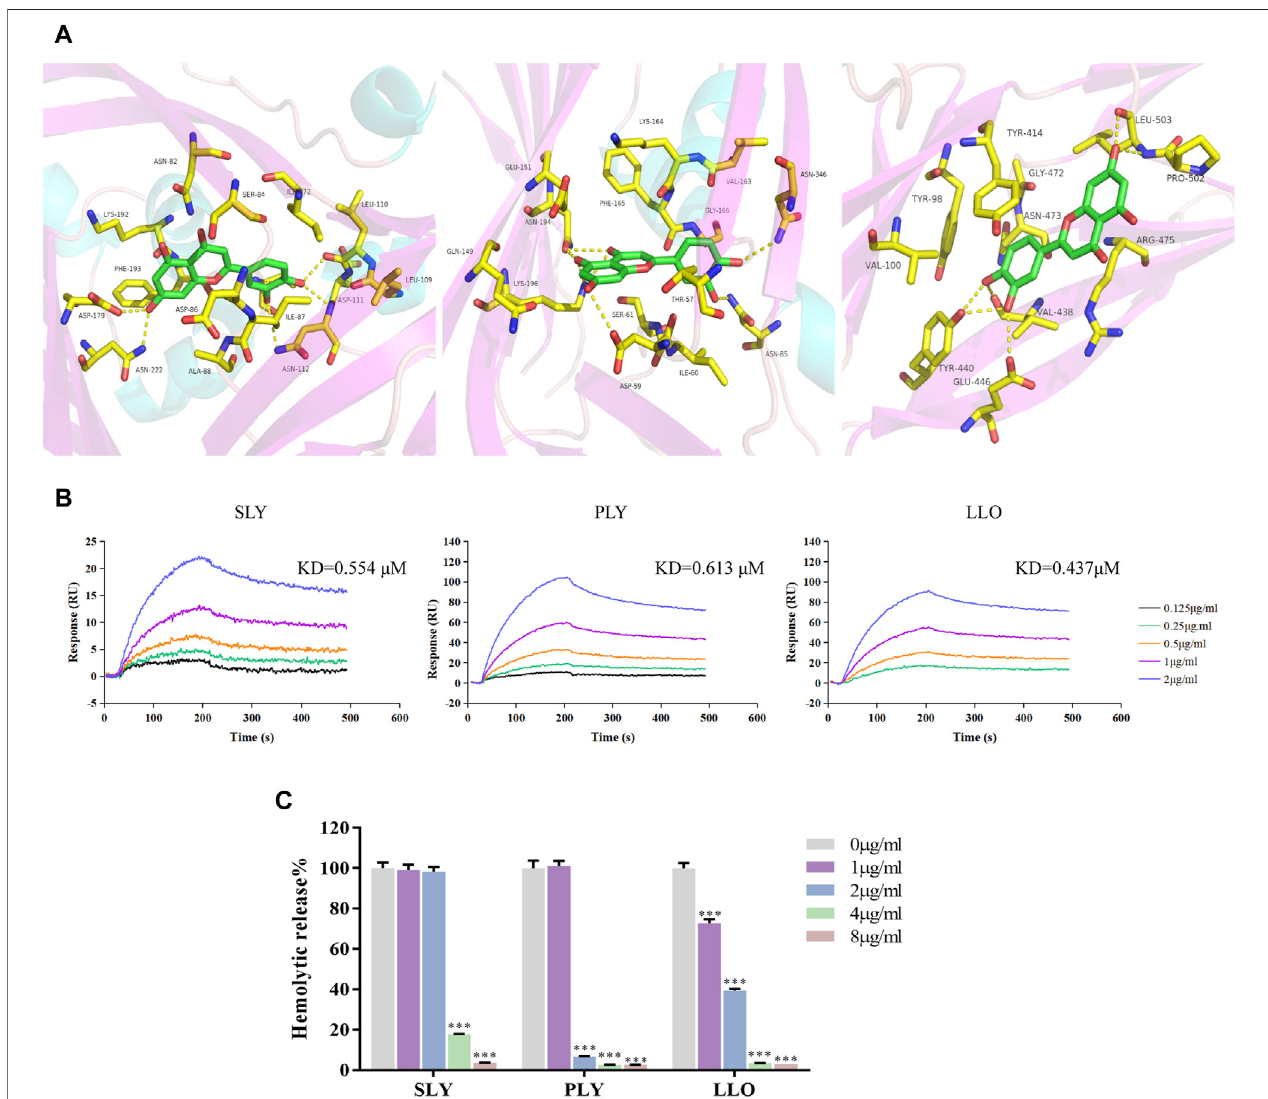
FIGURE 4 | Luteolin inhibits the hemolytic activity of SLY, PLY and LLO proteins. (A) The binding mode of luteolin with SLY, PLY and LLO. (B) Luteolin combined with SLY, PLY, and LLO. (C) Luteolin affects the hemolytic activity of SLY, PLY and LLO proteins. * p < 0.05; ** p < 0.01; *** p < 0.001; ns. indicates results were not signi fi